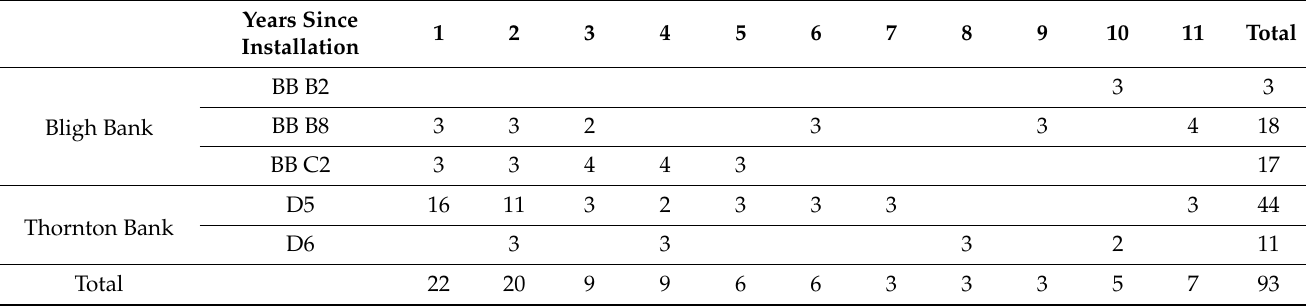
Table 1. Annual number of scrape samples per turbine per year obtained in the Bligh Bank and Thornton Bank OWF over time. Sampling in the Bligh Bank OWF started in 2009 and in 2008 in the Thornton Bank